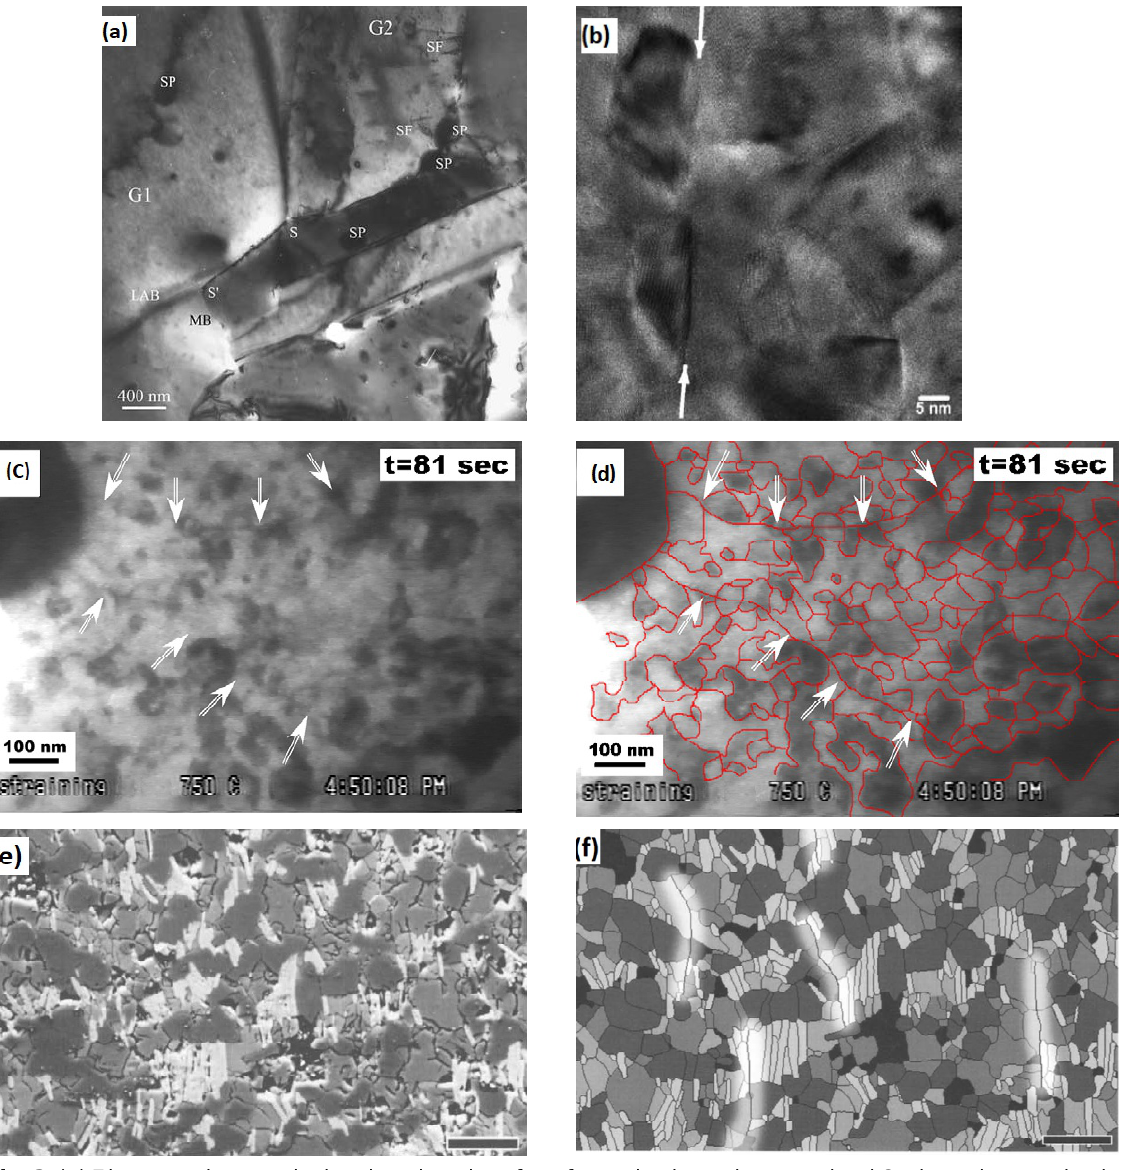
Fig. 3. (a) Electron micrograph showing plane interface formation in a micron-grained Cu-based superplastic alloy, adapted from Gouthama & Padmanabhan, 2003 [43]. (b) High resolution TEM micrograph of nanocrystalline Pd after rolling that shows plane interface formation extending over several grain boundaries (arrowed), adapted from Markmann et al., 2003 [44]. (c) TEM images after 81 s of deformation, taken just after the commencement of mesoscopic boundary sliding. Material tested: Nanocrystalline Ni “stringers” formed in (c), as highlighted in (d), adapted from Mara et al., 2007 [45]. (e) High magnification Back Scattered Electron (BSE) micrograph of a polished and etched ultra-mylonite showing evidence for plane interface formation. Scale bar: 30  m. (f) Line drawing after (e) showing the continuous alignment of grain and interphase boundaries across several grain diameters (mesoscopic boundary sliding); several of them are highlighted. Scale bar: 30  m (adapted from Fliervoet et al., 1997 [46]; proof through a TEM study is yet to be